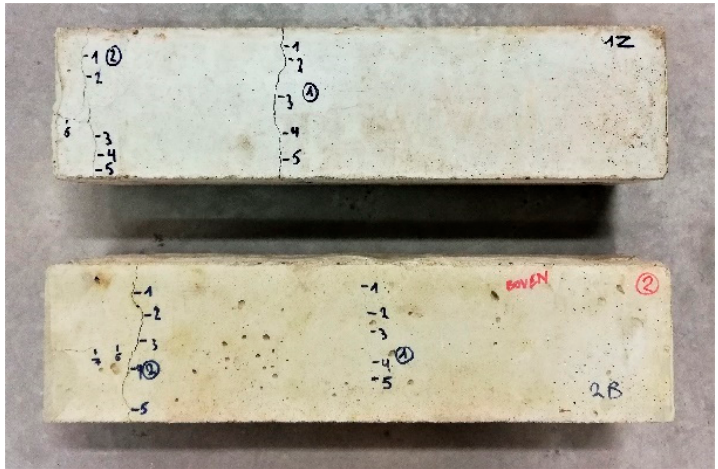
Figure 5. Specimens for visual crack healing with an indication of measurement locations. The reinforcement bar running along the length of the specimens has already been sawn off.